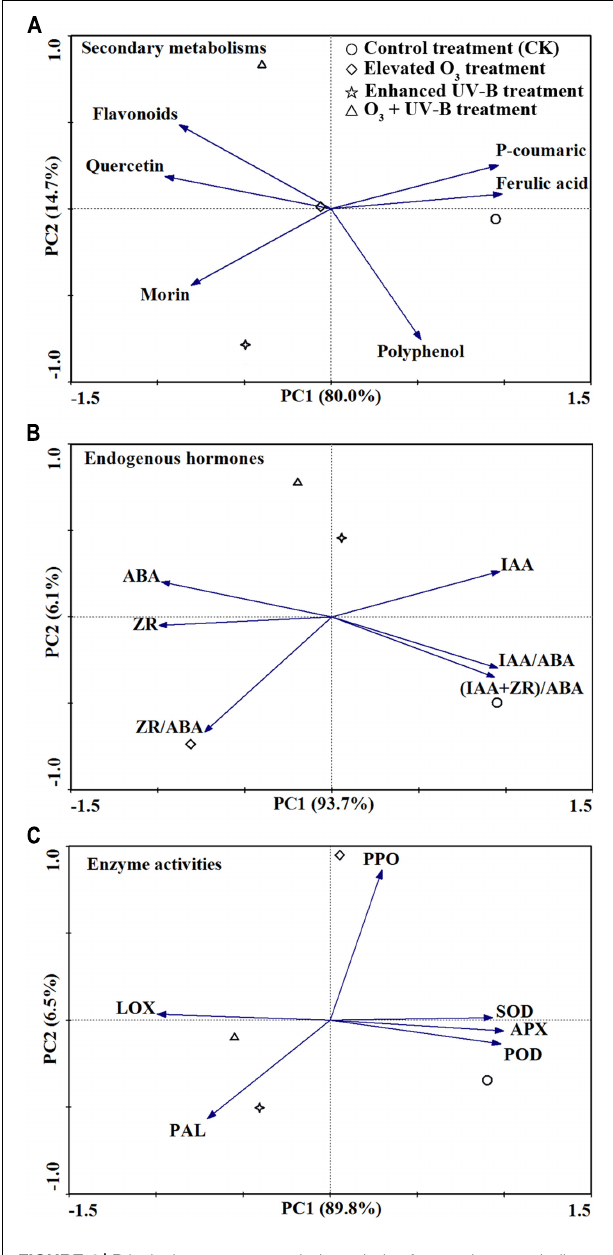
FIGURE 4 | Principal component analysis analysis of secondary metabolisms (A) , endogenous hormones (B) and enzyme activities (C) in response to control treatment (CK), elevated O 3 treatment, enhanced UV-B radiation treatment and O 3 + UV-B treatment at stages of branching, flowering, and